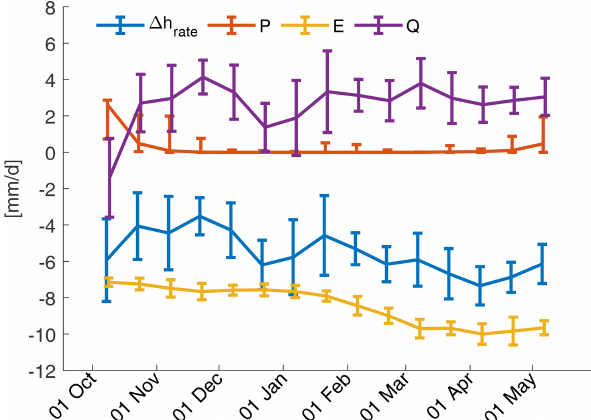
Figure 7. Rates of water balance components (lake level change: (cid:49)h rate , net inflow: Q , precipitation: P , evaporation: E ) during the dry season (1 October until 15 May). The lines and error bars in- dicate the mean and standard deviation, respectively, over available data points for 15d periods. For precipitation the median and the 95% confidence interval are shown instead of the mean and the standard deviation.